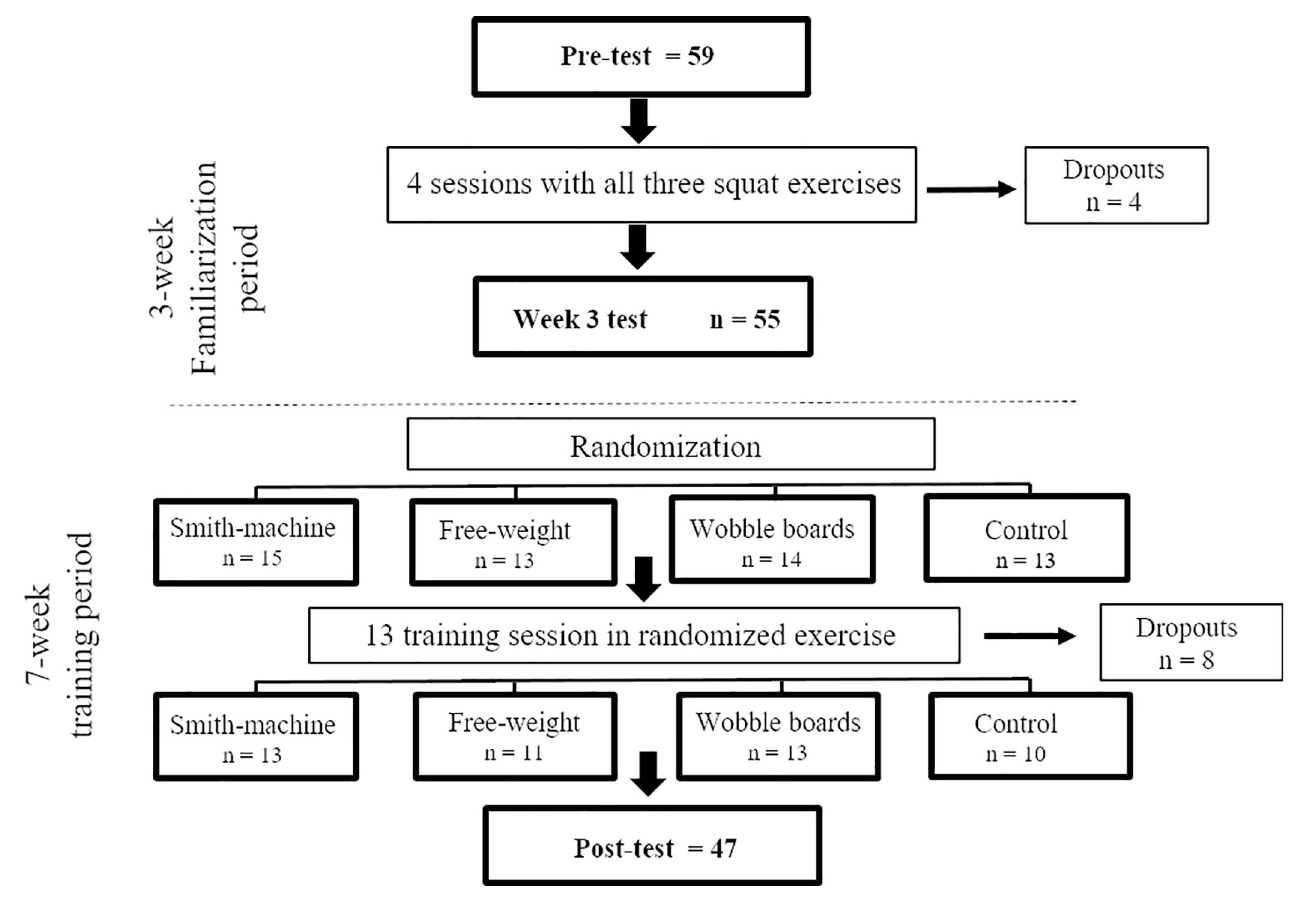
Fig 1. An overview of the study.